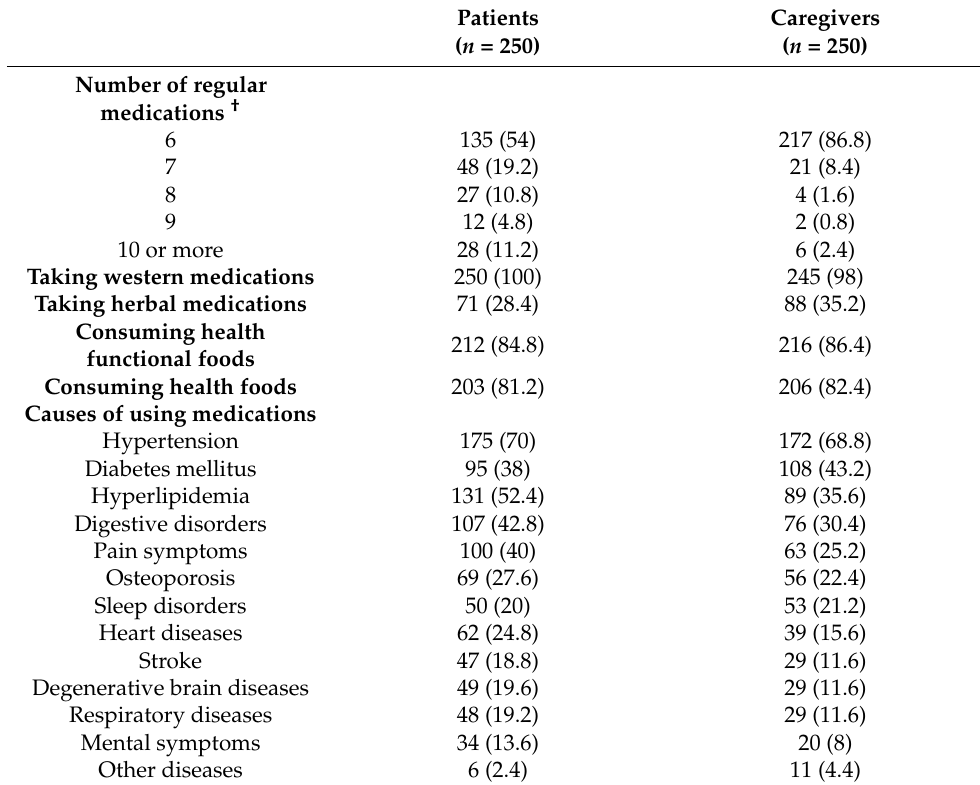
Table 2. Current status of medication